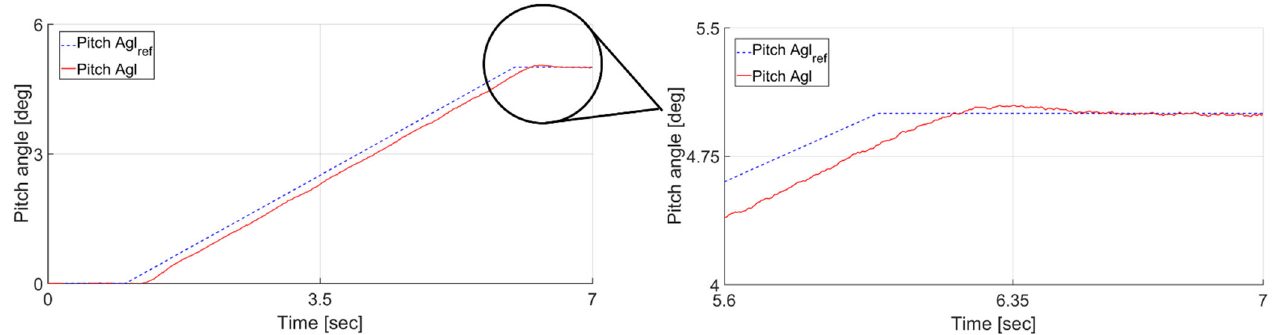
Figure 9. Pitch direction bending response.